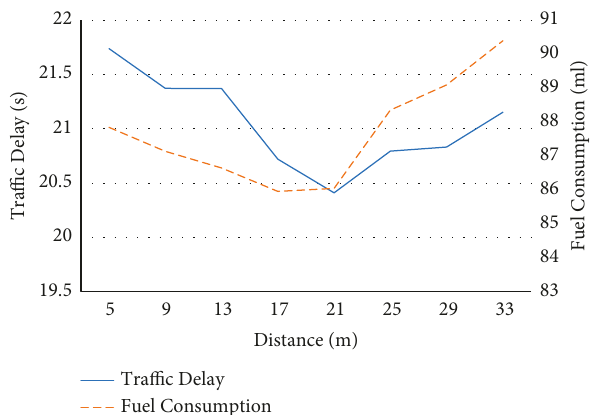
Figure 2: Performances of platooning with different values of distance